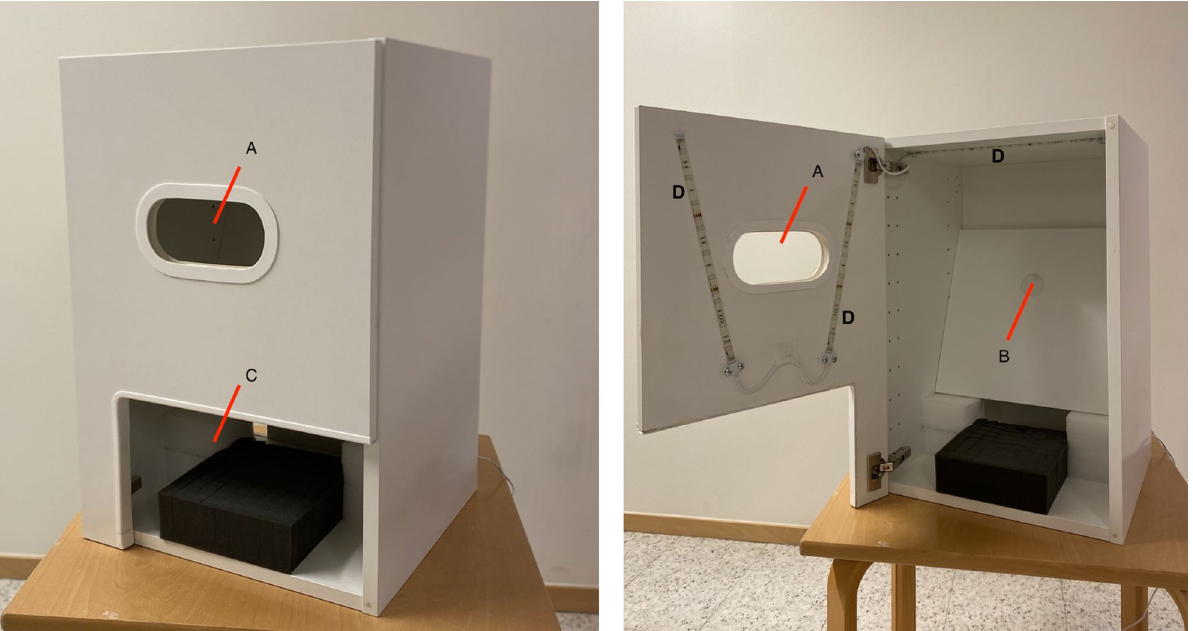
Figure 1. The box used for the experimental trial. Participants looked into the box to view their non-dominant hand, or other stimuli through ( A ), while their forehand touched the cabinet (left picture). LED strips inside the box (right picture) provide constant and uniform illumination. The non-dominant hand or objects were placed at a diagonal piece of wood ( B ). The gap at the lower front ( C ) was designed for inserting the non-dominant hand, and resting it on the ( B